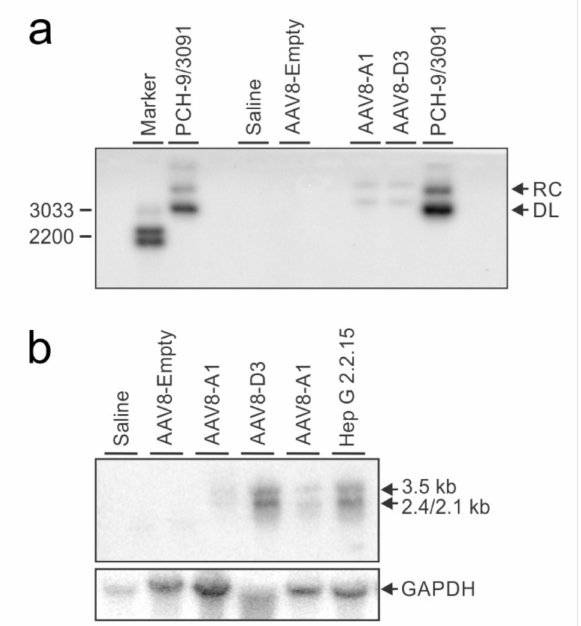
Figure 4. Detection of HBV replication intermediates. ( a ), HBV DNA intermediates from livers of mice extracted 24 weeks post-injection with saline or 9 × 10 11 AAV VPEs/mouse. The pCH-9/3091 plasmid carrying HBV genotype D sequence was included as a control to verify probe hybridisation. Arrows indicate relaxed circular (RC) and double-stranded linear (DL) DNA. ( b ), RNA intermediates from the livers of mice extracted 24 weeks post-injection with saline or 9 × 10 11 AAV VPEs/mouse. RNA extracted from Hep G 2.2.15 cells was included as the positive control. Arrows indicate pre- genomic RNA (3.5 kb) and sub-genomic RNAs (2.4 kb and 2.1 kb). The blot was re-probed with a GAPDH -specific probe to verify equal loading of the